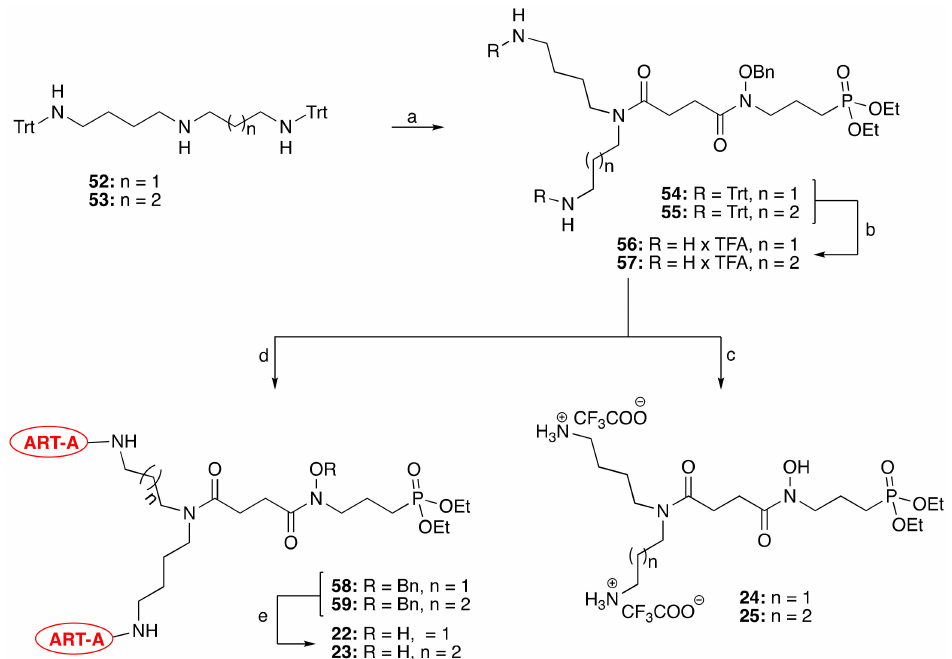
Scheme 4. Synthesis of the FSM-ART conjugates 22 – 23 and FSM derivatives 24 – 25 ; Reagents